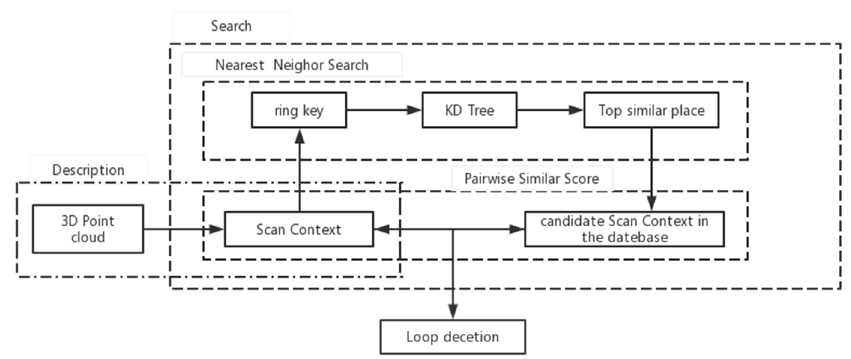
Figure 3. Loop detection algorithm overview.